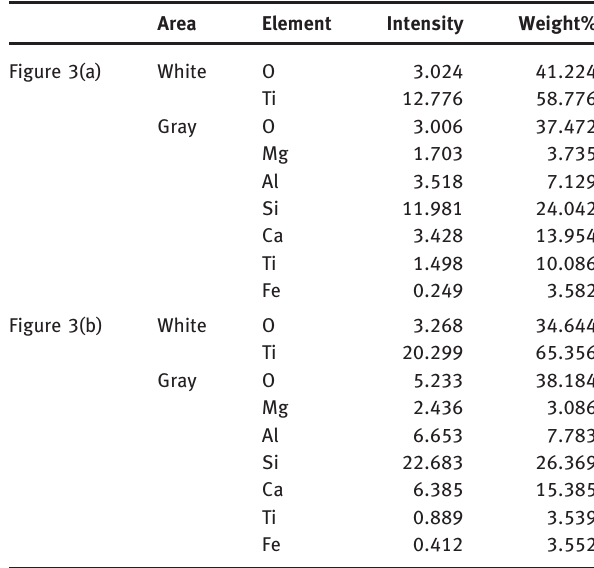
Table 2: EDS analysis results of Figure 3. Area